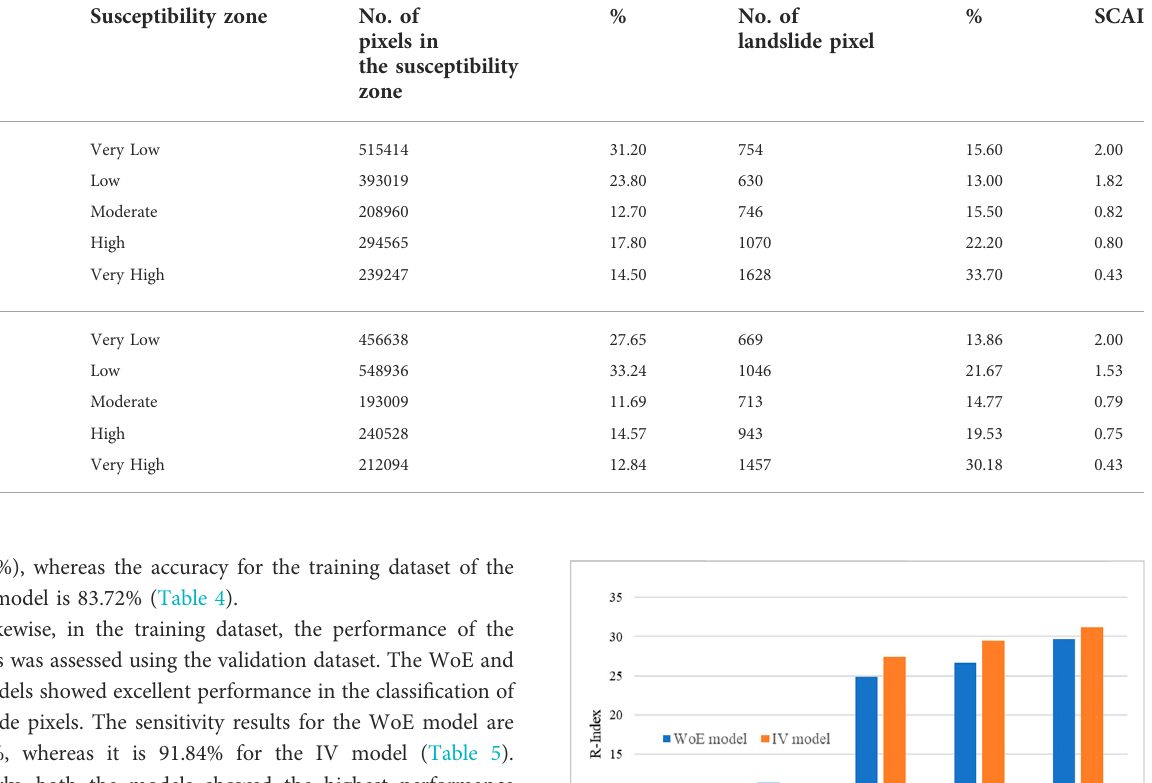
TABLE 6 WoE and IV model result validation based on seed cell area index (SCAI).